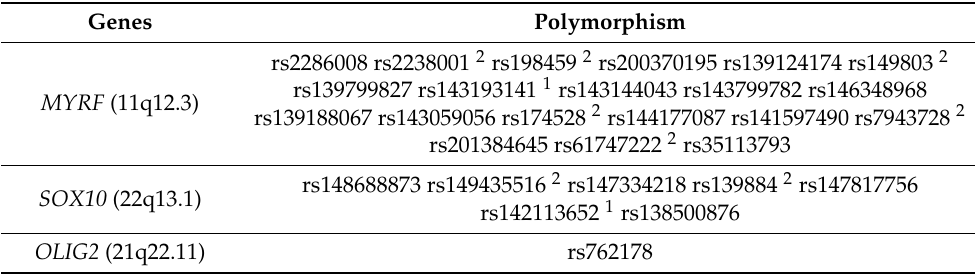
Table 3. Analyzed single nucleotide